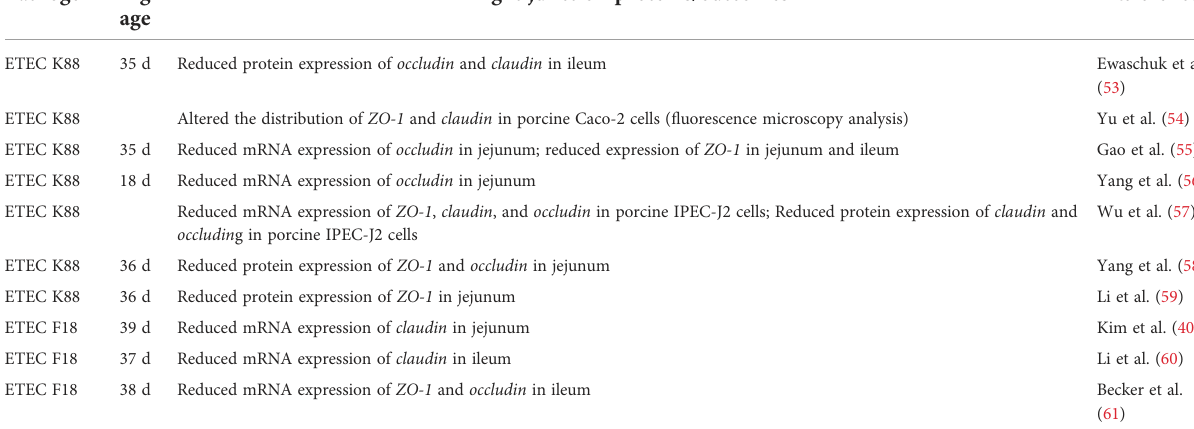
TABLE 1 Enterotoxigenic Escherichia coli (ETEC) altered the expression of tight junction proteins in the small intestine of pigs in vivo or epithelial cells in vitro . Pathogen Pig Tight junction age